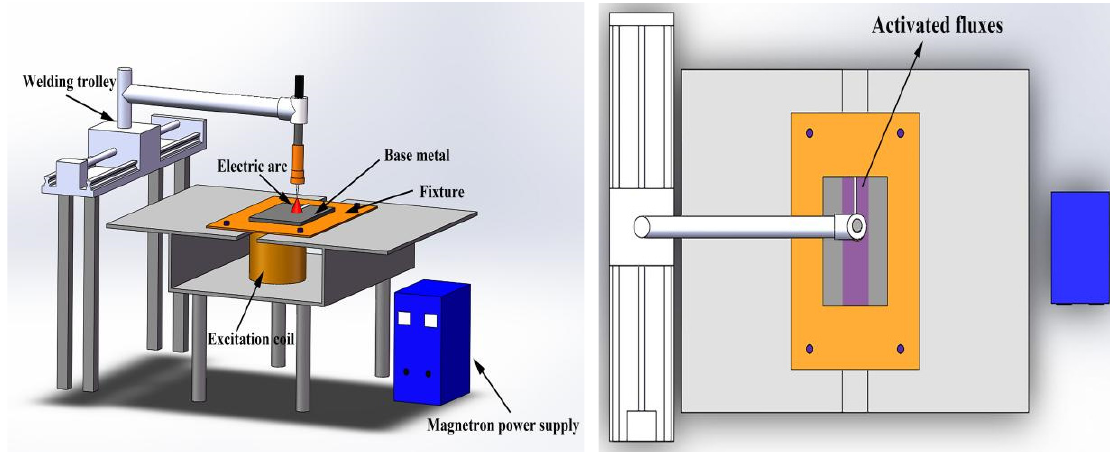
Figure 1. Welding device diagram and top view.